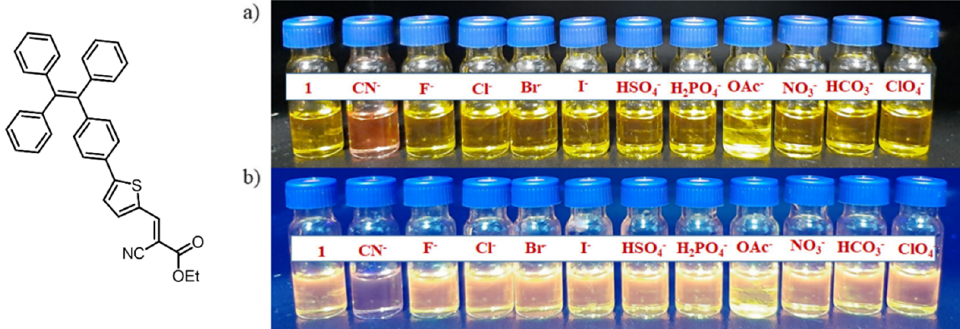
Figure 9. A photograph representing the sensing performance of the probe towards CN − ion in an aqueous solution in the presence of other anions under: ( a ) visible light and ( b ) UV light (365 nm). Reprinted from reference [60] with the permission of the American Chemical Society.